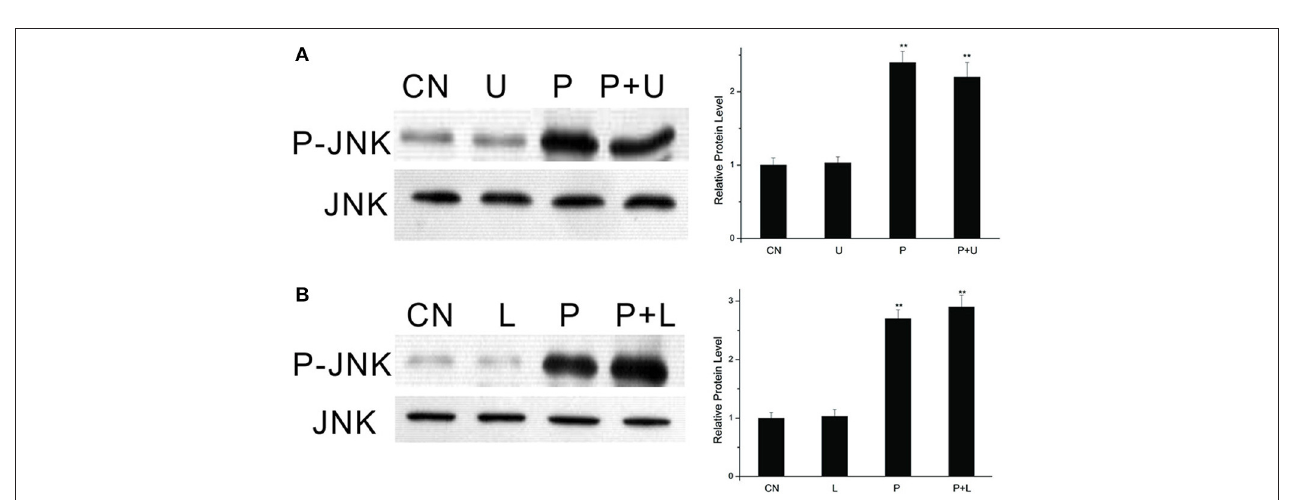
FIGURE 4 | Effects of U0126 (A) and LY294002 (B) on PTTH-stimulated JNK phosphorylation. PGs were pretreated with either 10 µ M U0126, 50 µ M LY294002, or control medium for 30min, and then transferred to medium containing the same dose of each inhibitor, with or without the PTTH. CN, PGs incubated in control medium; P, PGs incubated in medium containing the PTTH only; U, PGs incubated in medium containing U0126 only; P + U, PGs incubated in medium containing both the PTTH and U0126; L, PGs incubated in medium containing LY294002 only; P + L, PGs incubated in medium containing both the PTTH and LY294002. The incubation time was 60min. Gland lysates were prepared and subjected to an immunoblot analysis with anti-phospho-JNK (P-JNK) and anti-JNK (JNK) antibodies. Results shown in the left panels are representative of three independent experiments. Data are expressed as multiples of change over the respective control after being normalized to the level of JNK. Asterisks indicate a significant difference compared to the respective control (by Student’s t -test, ** p <